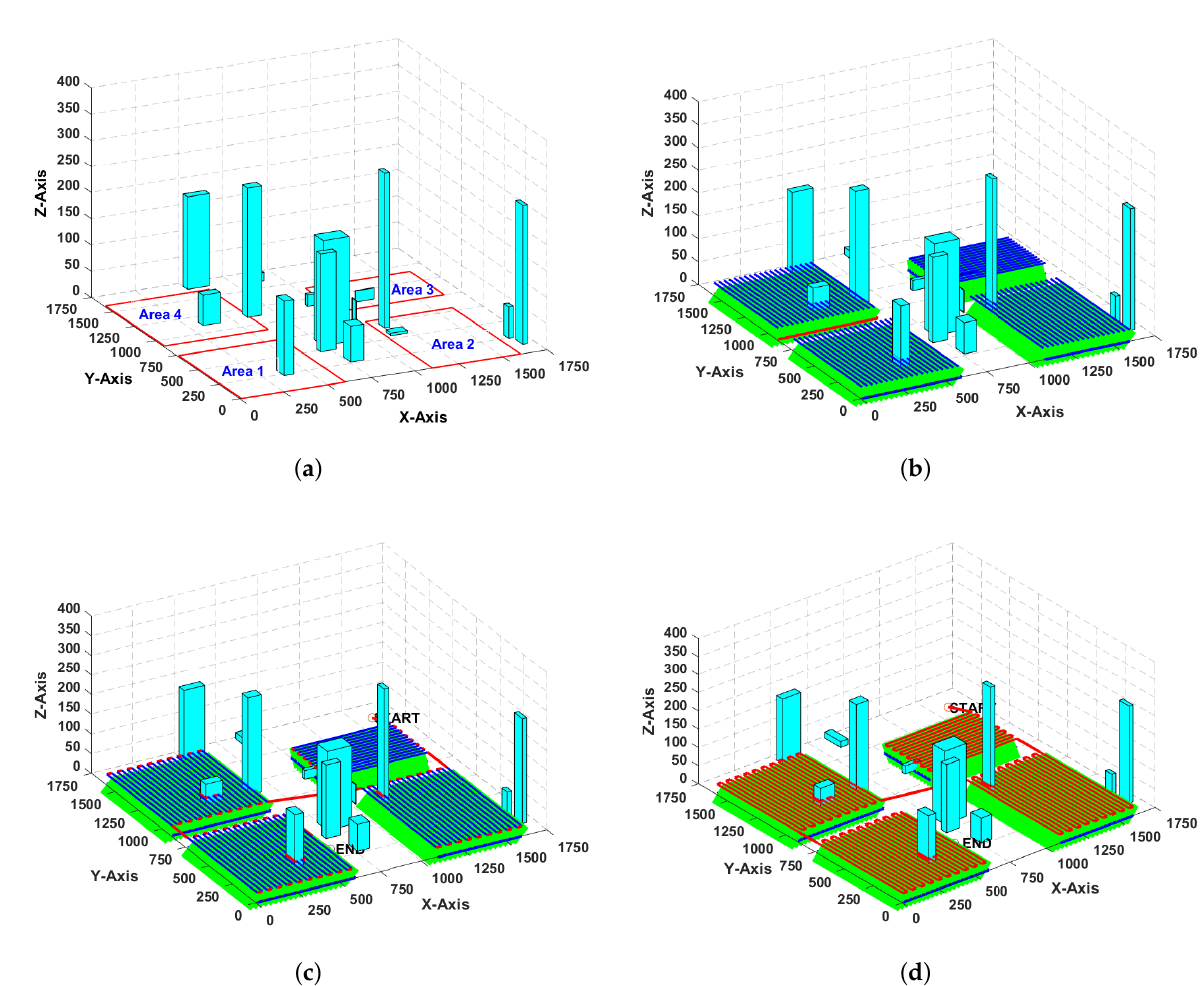
Figure 17. Pictorial overview of the coverage path computed by the proposed CPP algorithm. ( a ) Overview of an urban environment and the AOIs located in it. ( b ) Overview of the sensor’s footprints sweeps. ( c ) SWG obtained by connecting footprints sweeps. ( d ) Complete coverage flight path for a